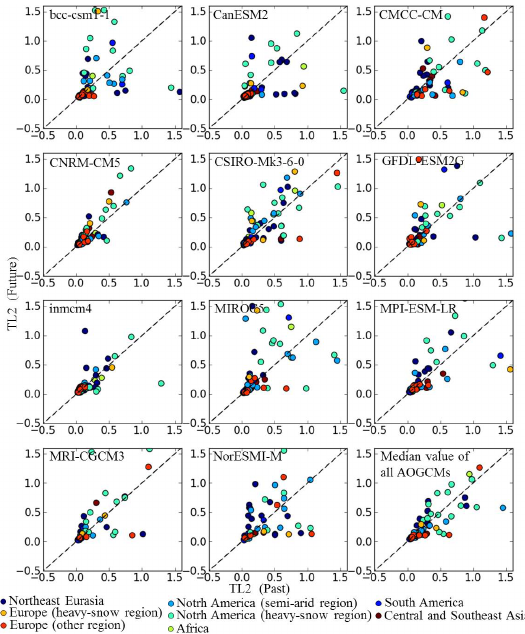
Fig. A2. Comparisons of the coefficient of variation of low flow (FL2) between past and future in each of the 11 coupled atmosphere–ocean general circulation models.